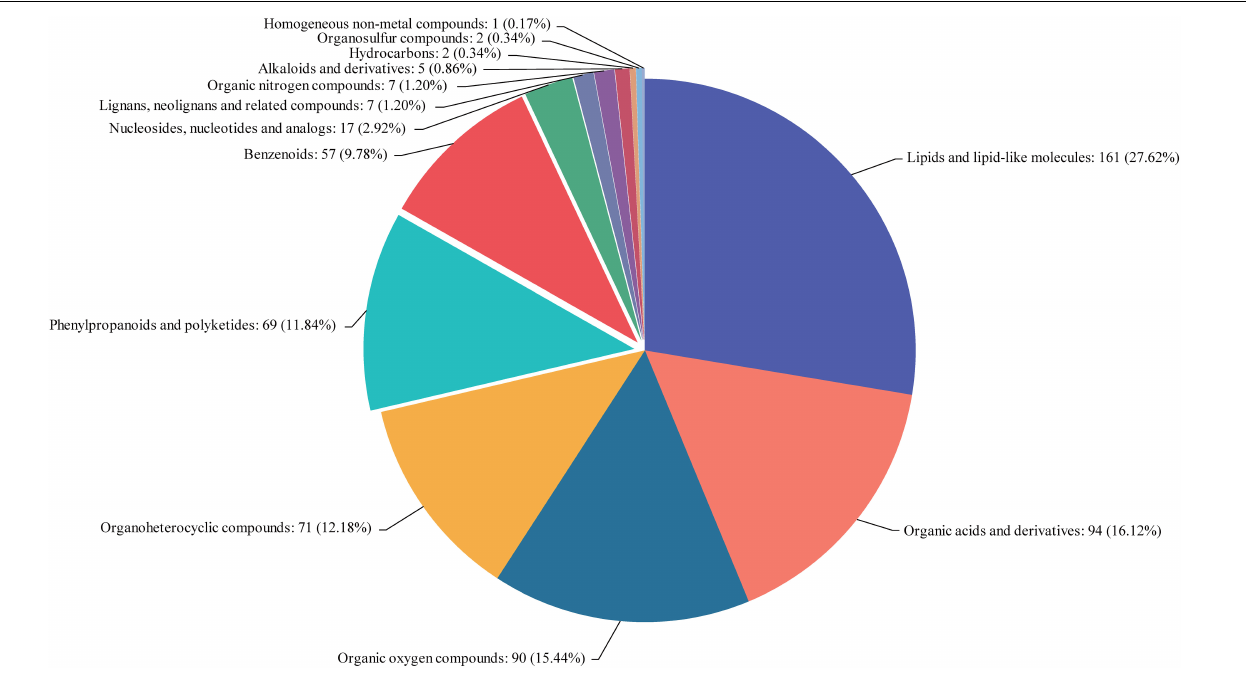
FIGURE 3 | Classification statistics of compounds. Names of the selected HMDB levels (superclass, class, or subclass) and percentage of metabolites are displayed in order from high to low depending on the number of metabolites. Different colors in each pie chart represent different HMDB classifications, whose area represents the relative proportion of metabolites in that